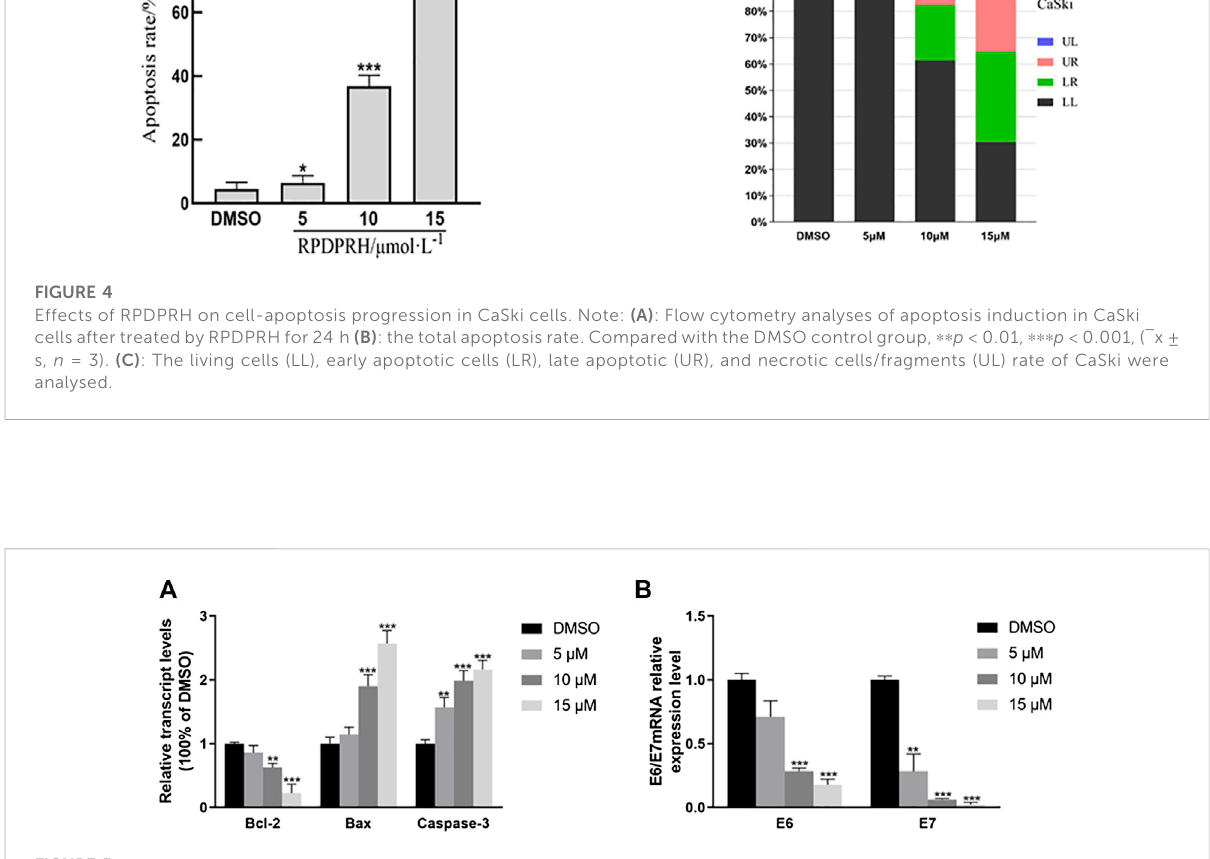
FIGURE 5 The effect of RPDPRH on the expression of mRNA in CaSki cells. Note: (A) : The mRNA expression of Bcl-2, Bax, and Caspase-3. (B) : The mRNA expression of E6/E7. Compared with the DMSO control group, p p < 0.05, pp p < 0.01, ( ‾ x ± s, n =